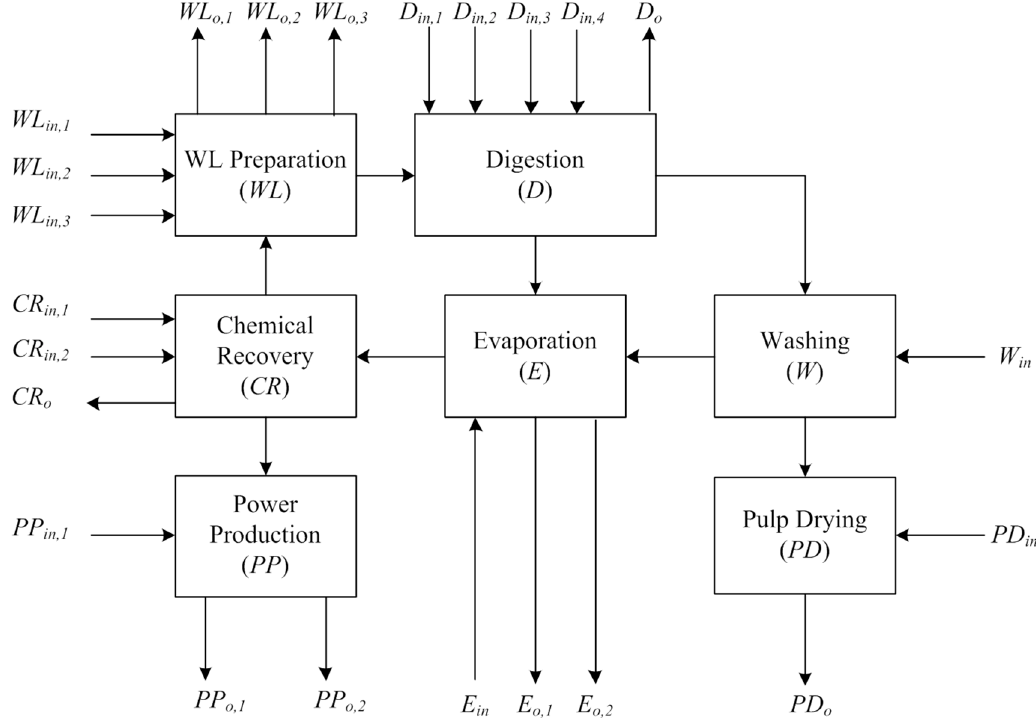
Figure 1. Flowsheet of pulping process.